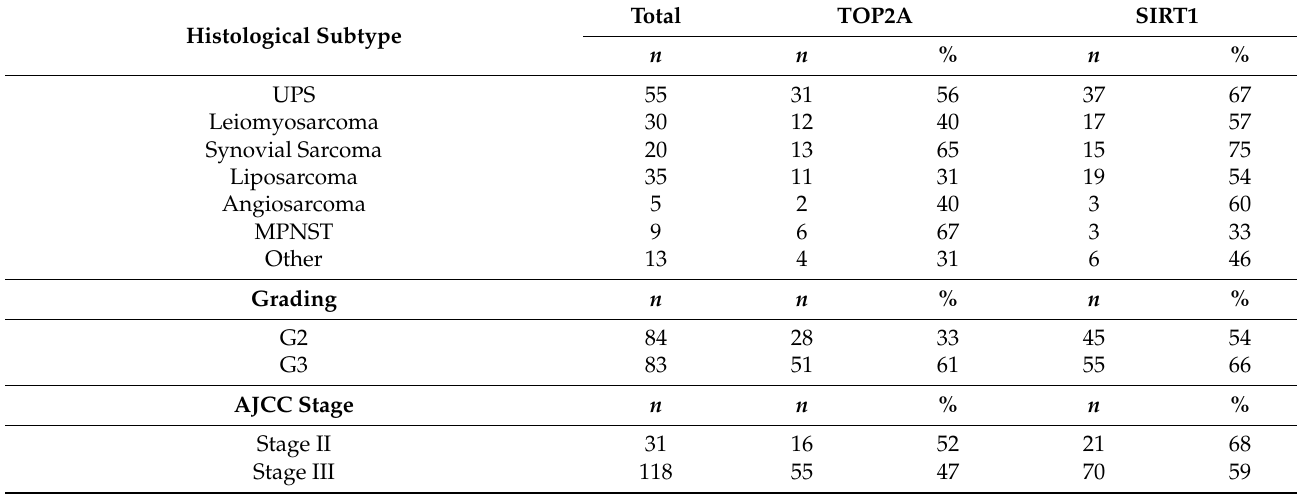
Table 2. Candidate biomarker TOP2A and SIRT1 expression according to histological subtype, grading and AJCC stage. The table shows the number and percentage of patients with high TOP2A and SIRT1